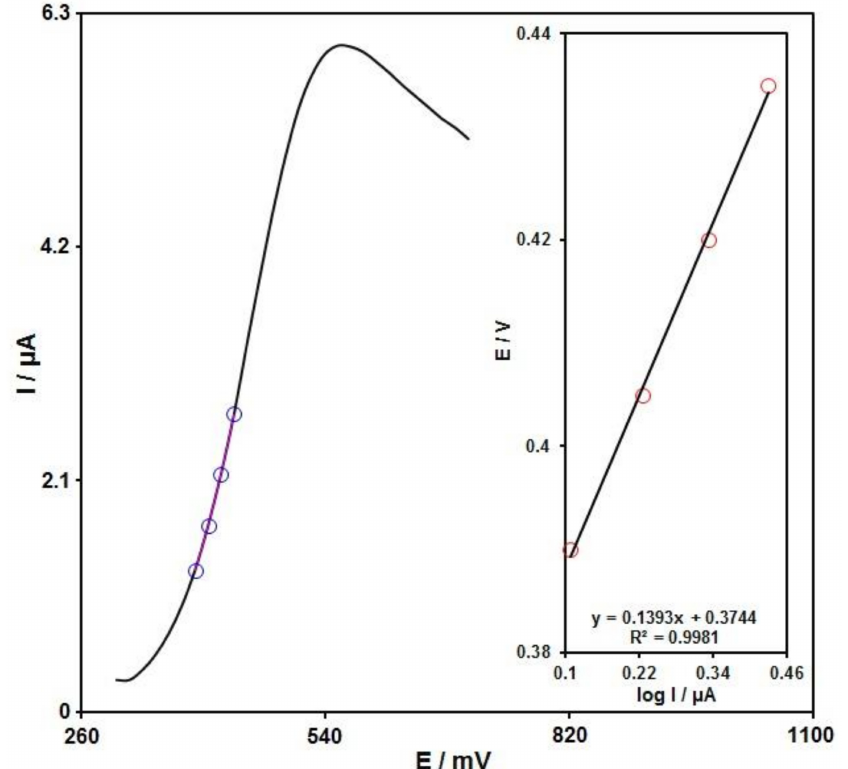
Figure 8. LSV for sumatriptan (100.0 µ M) at the scan rate of 10 mV/s. Inset: The Tafel plot from the rising domain or the respective